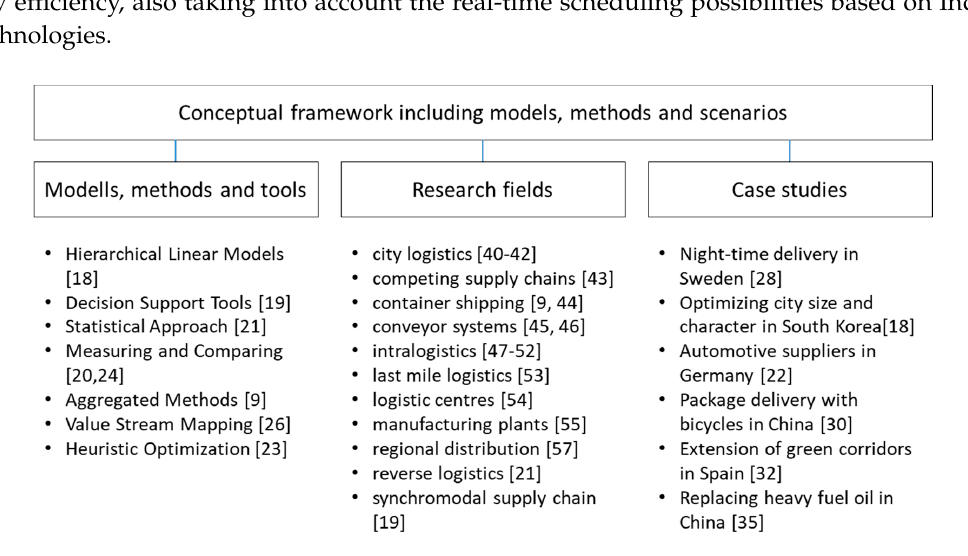
Figure 5. Conceptual framework for modelling categories of energy efficiency in supply chain solutions and logistics systems.